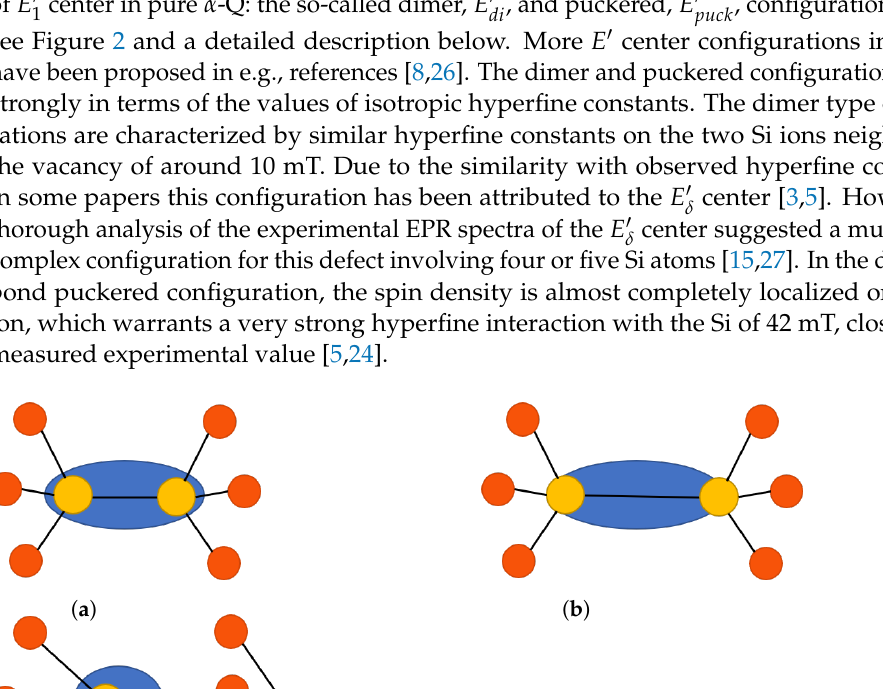
with elongated Si-Si bonds. ( c ) Puckered di